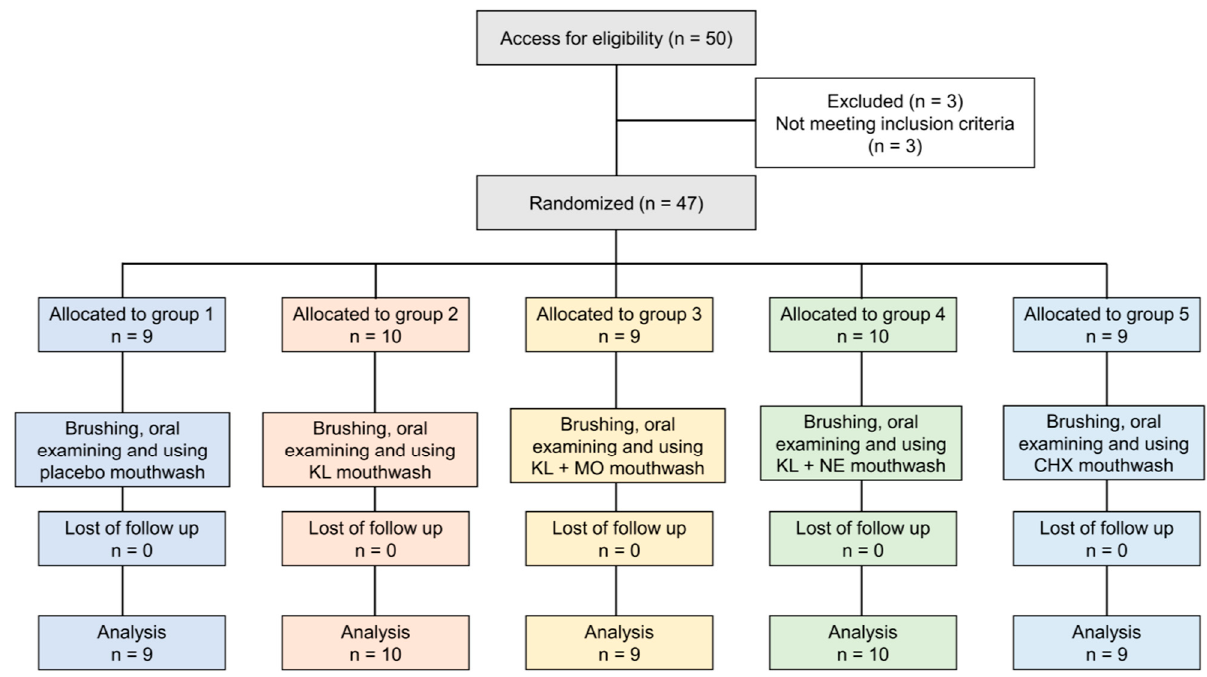
Figure 3. Flow chart of the study.